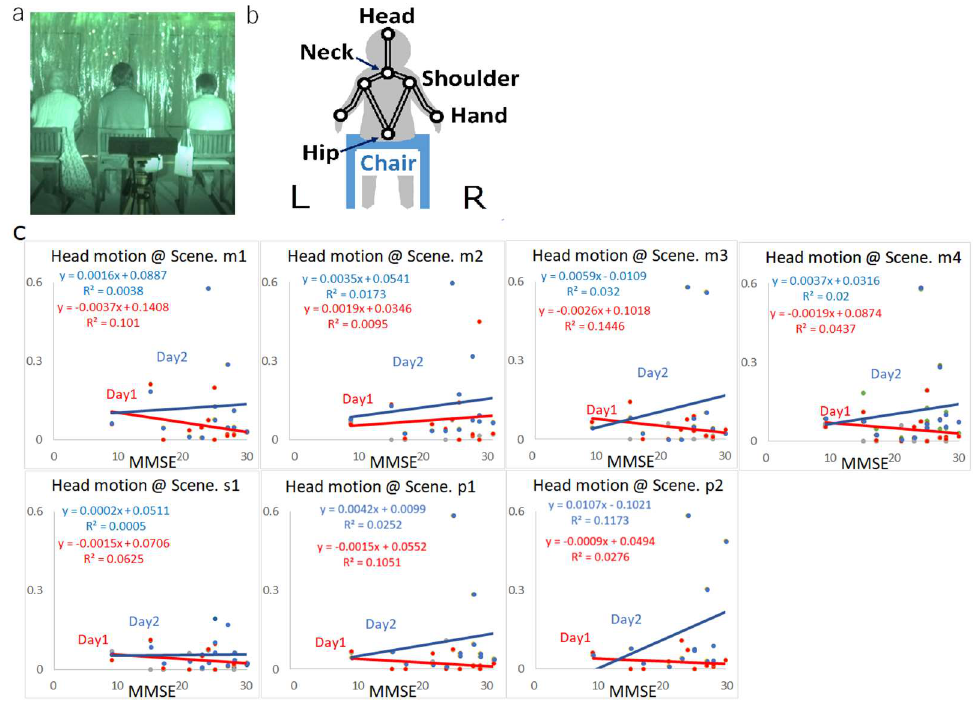
Figure 3. Behavioral alteration from Day 1 to Day 2 considering cognitive scores. ( a ) An example of three subjects at the digital art installation with a Kinect sensor to detect participants’ motion (a black rectangle on a tripod). ( b ) Identification of the seven body joints assessed. ( c ) An example of motion (head motion for the thirteen participants) correlation with MMSE by linear regression analysis on Day 1 (red) and Day 2 (blue). Formulas and R 2 for each regression line are presented (red = Day 1; blue = Day 2).